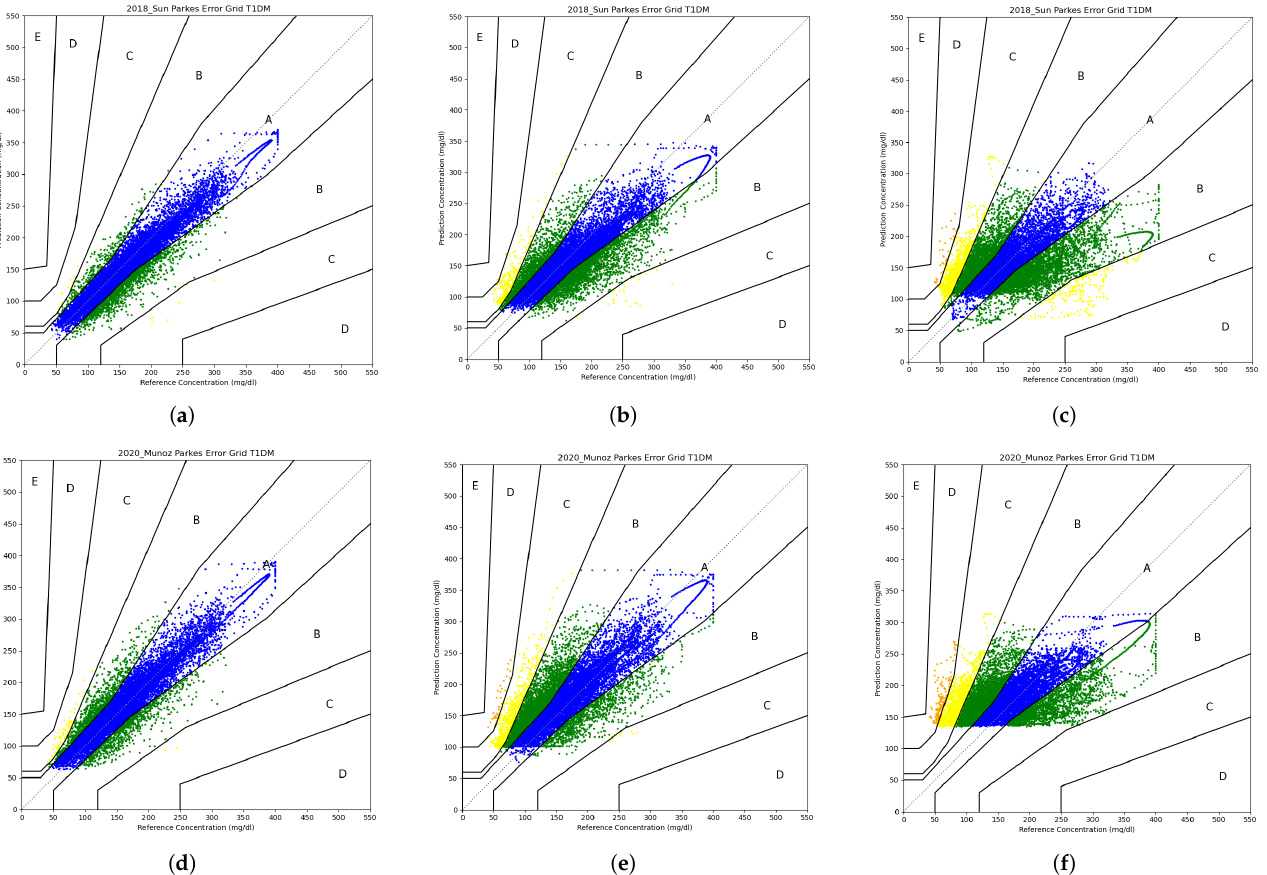
Figure 6. Parkes error grid for the models with the highest and lowest number of predictions in A zone. ( a ) Sun PEG ph = 30min. ( b ) Sun PEG ph = 60min. ( c ) Sun PEG ph = 120min. ( d ) Muñoz PEG ph = 30min. ( e ) Muñoz PEG ph = 60min. ( f ) Muñoz PEG ph =